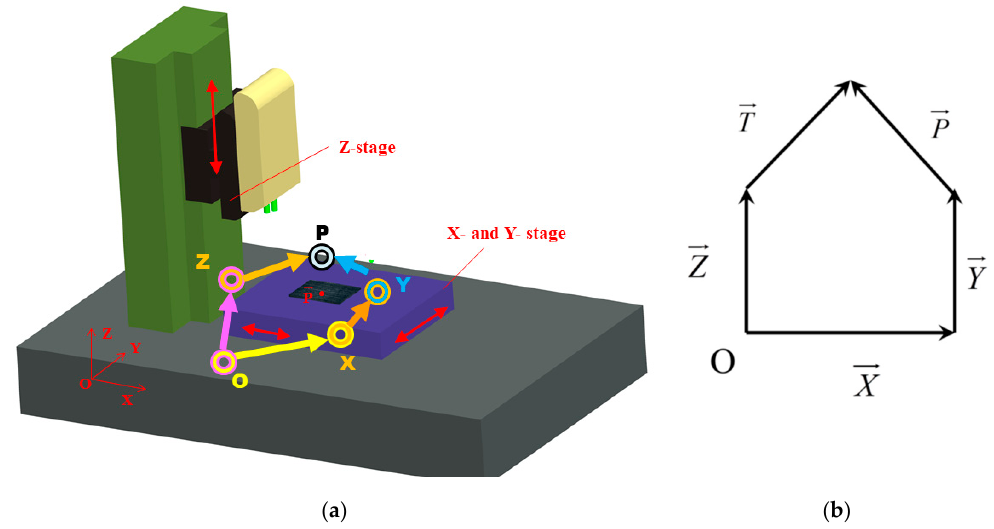
Figure 1. Manifestation of the vectors in 3D Imaging CM: ( a ) 3D view; ( b ) diagram of the axis chain vector.